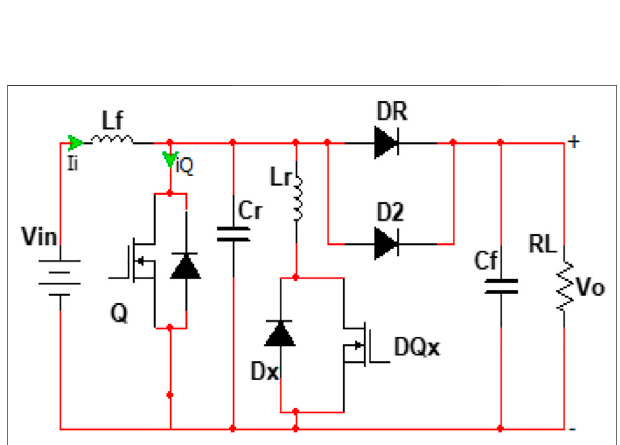
FIGURE 5 | Topology of basic ZVT soft-switching Boost circuit.